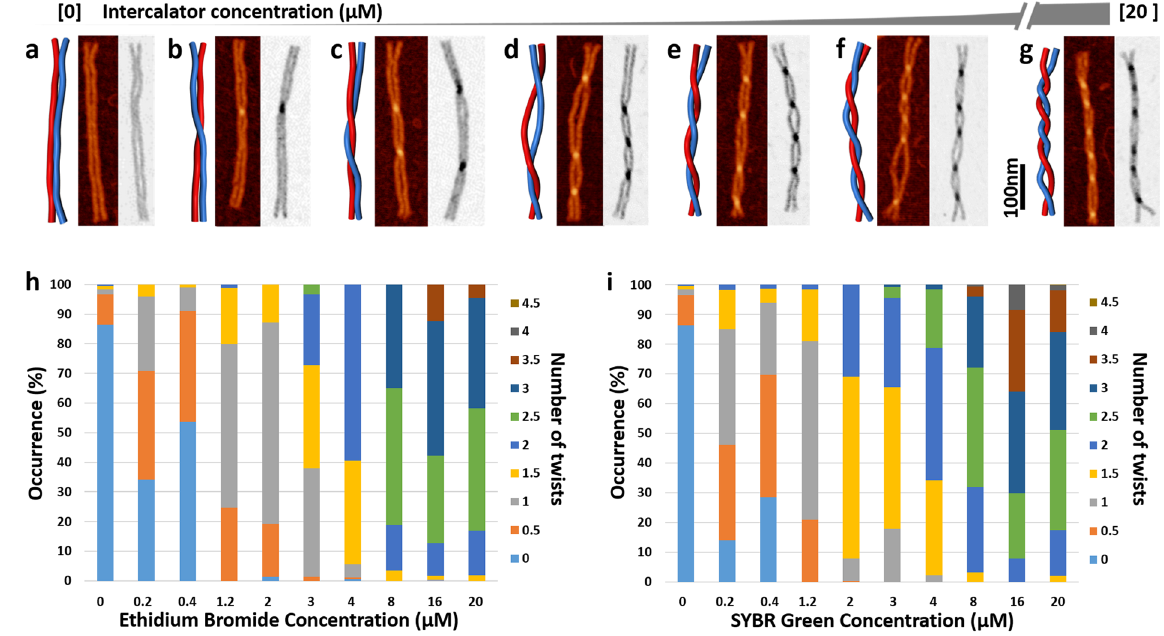
Figure 2. Illustrations and corresponding AFM images showing global twisting of DNA nanorails as a function of the dye concentration (EtBr is colored and SG is in black and white). Global twisting was not observed without EtBr or SG in ( a ) and increased as the [dye] increased from 200 nM ( b ) to 1.2 µ M ( c ), 3 µ M ( d ), 4 µ M ( e ), 8 µ M ( f ), and 16 µ M ( g ). Summary of twisting effect of intercalators on DNA nanorails for samples treated with EtBr ( h ) and SG ( i ). Occurrence refers to the frequency of each individual state in the total number of particles counted for each data set.